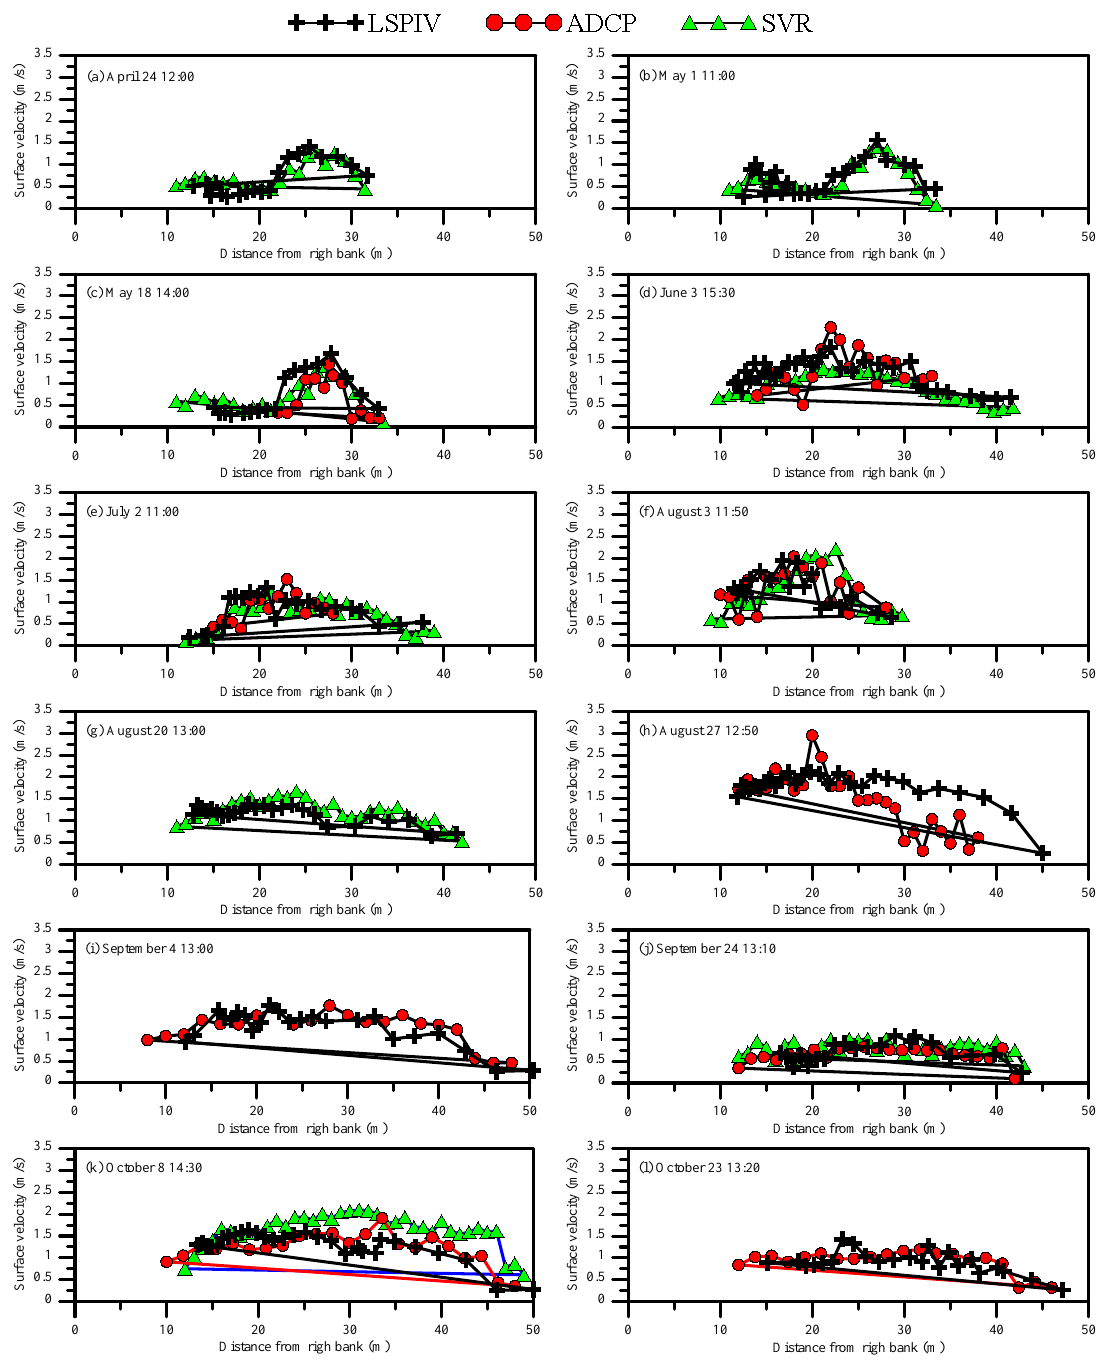
Figure 6. Comparison of surface velocities measured by LSPIV, ADCP, and SVR on different dates under normal flow conditions: ( a ) 24 April, ( b ) 1 May, ( c ) 18 May, ( d ) 3 June, ( e ) 2 July, ( f ) 3 August, ( g ) 20 August, ( h ) 27 August, ( i ) 4 September, ( j ) 24 September, ( k ) 8 October, and ( l ) 23 October in the year of 2015. Figure 7 shows a scatter plot for the averaged surface velocities from LSPIV and ADCP (or SVR) measurements. Also, the normalized root mean square error NRMSE, which is a statistical indicator, was used to quantify the accuracy, i.e.,